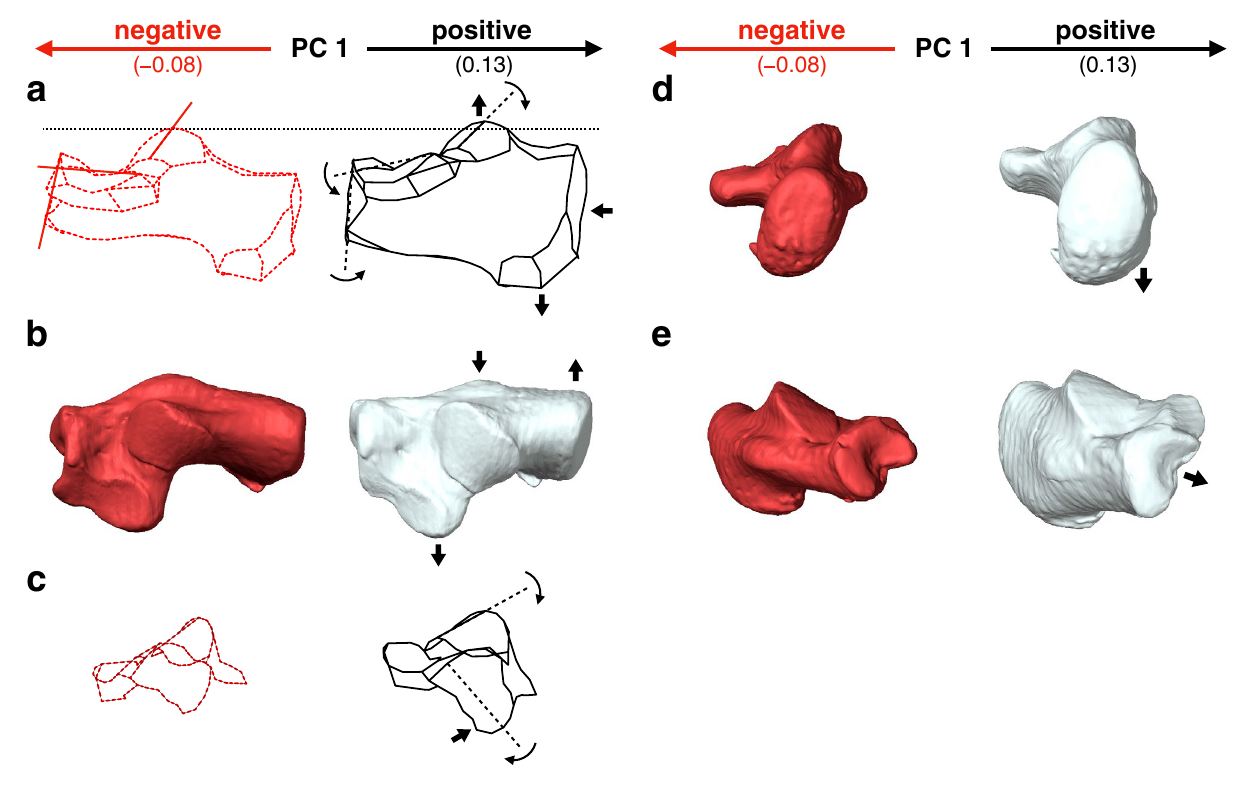
Figure 3. Shape variations represented by PC1 in the whole-sample analysis. Shape variations are visualized using the wireframe connecting primary landmarks and the template surface deformed using a thin-plate spline function. Black line and white surface: PC1 = 0.13. Red line and red surface: PC1 = − 0.08. Black arrows indicate characteristics of the positive score. The medial ( a ), superior ( b ), posterior views of the anterior ( c ) and posterior ( d ) parts, and anterolateral ( e ) views were